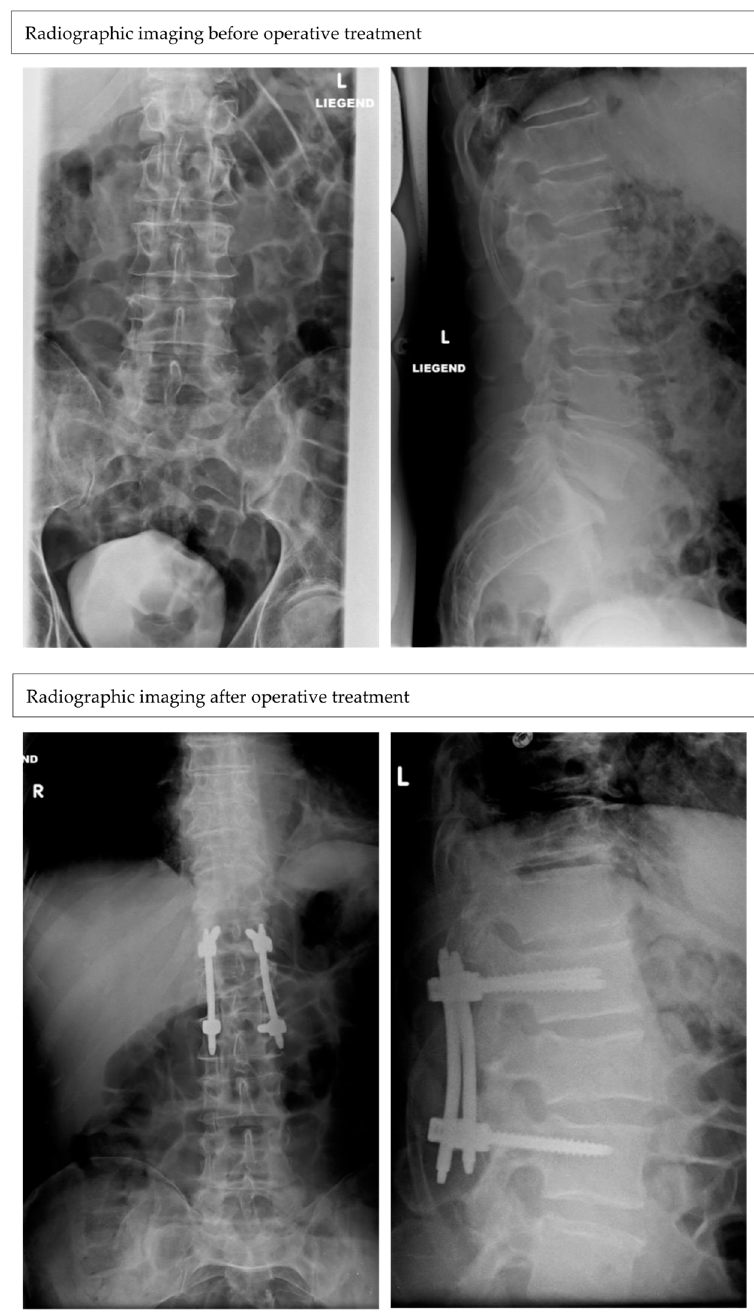
Figure 3. Radiographs (anterior–posterior and lateral) of a patient, 62 years old, with an A3 fracture of L1 after a car crash, before and after operative treatment with a dorsal stabilization. Postoperative reduction was still present after the last